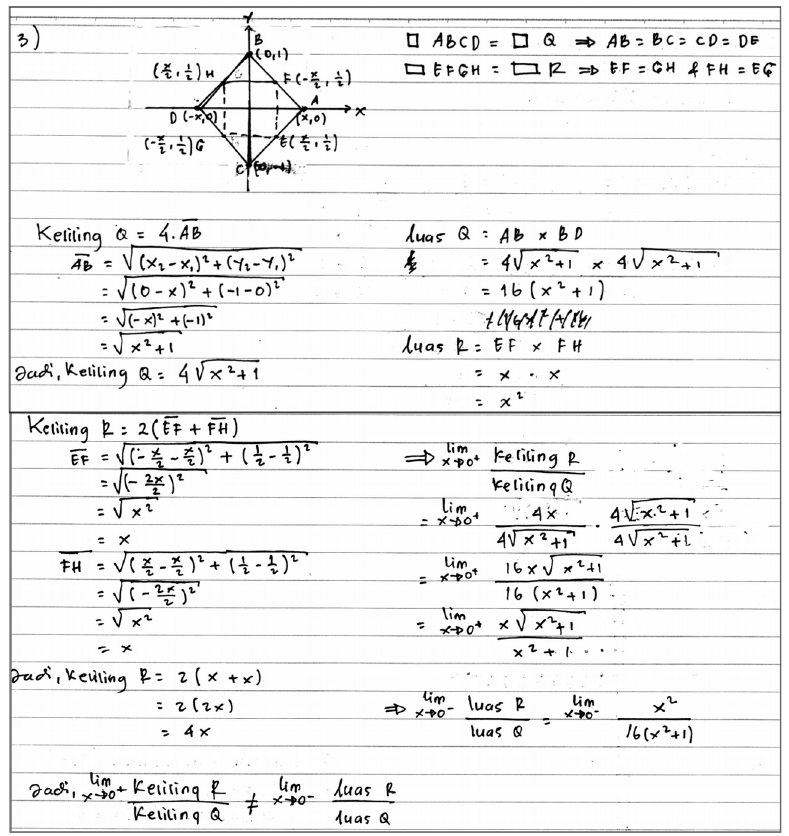
Figure 3. Example of Student